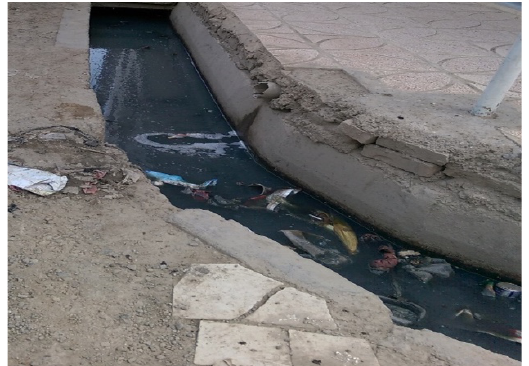
Figure 3. The undesirable condition of Surface runoff collection system